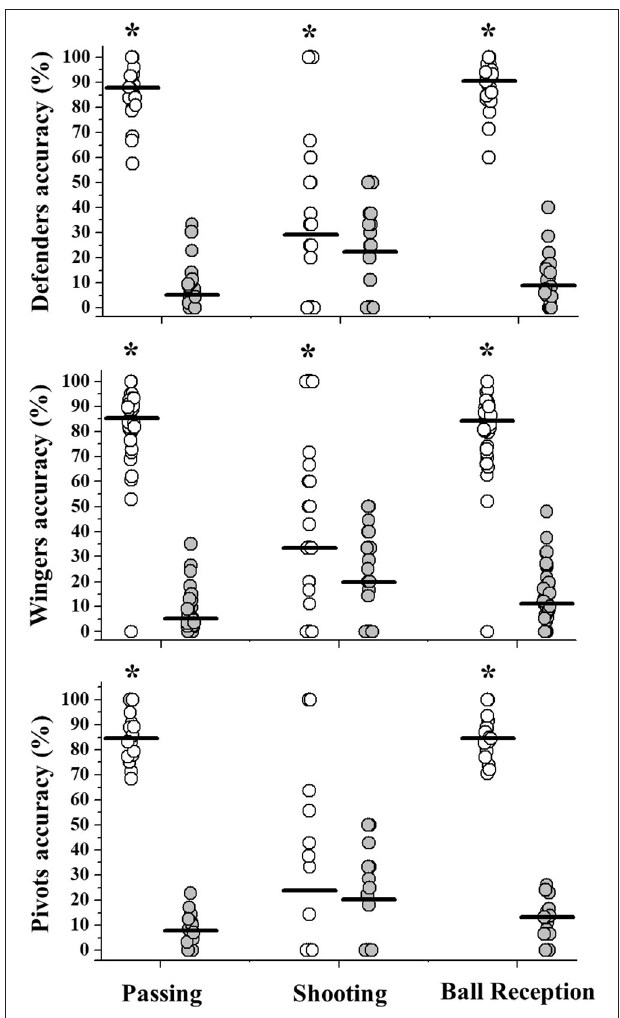
FIGURE 3 | Accuracy (%) values observed for defenders, wingers, and pivots using the dominant (open symbols) or non-dominant limb (gray symbols). Horizontal lines represent the group median values. *Significant differences between limbs observed through Wilcoxon’s test ( p < 0.05).